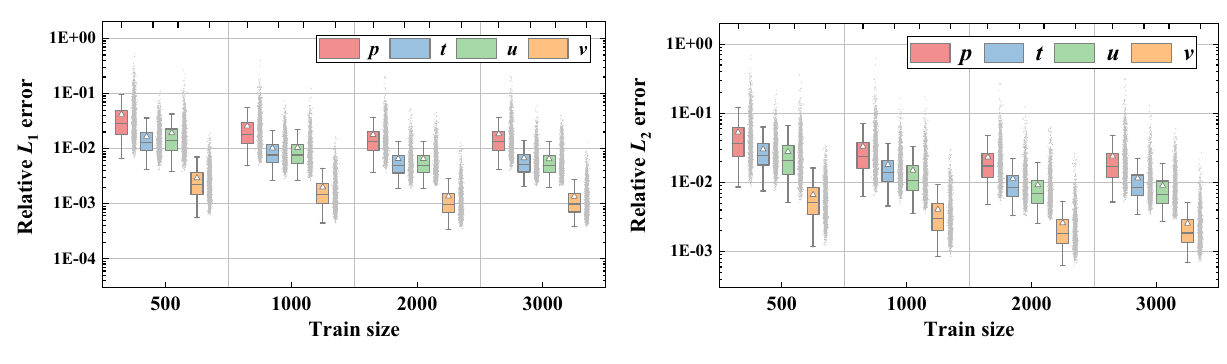
Figure 9. Relative L 1 and L 2 errors vs. Train